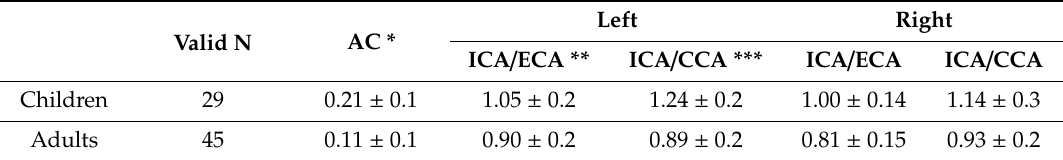
Table 1. Descriptive statistics of the ultrasound data.